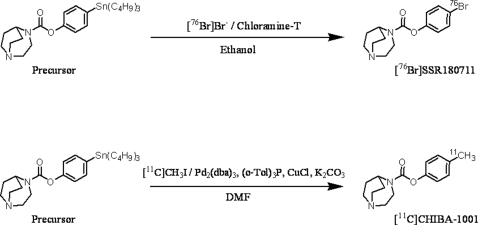
Synthesis of [76Br[SSR180711 and [11C]CHIBA-1001.